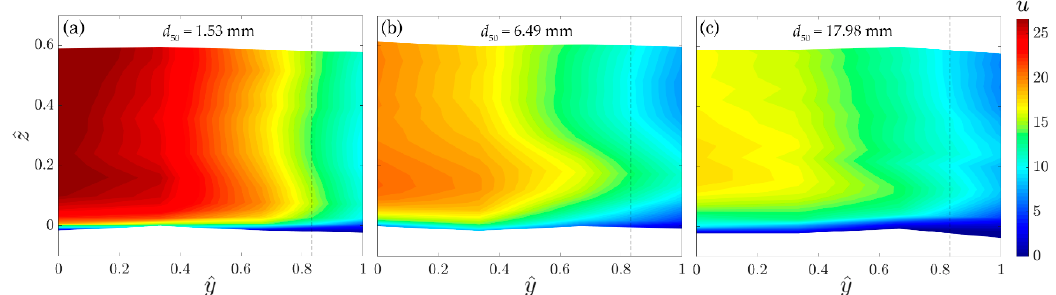
Figure 7. Contours of the dimensionless time-averaged streamwise velocities on the lateral plane (from D to A) for ( a ) Run 1, ( b ) Run 2, and ( c ) Run 3. The black broken line indicates the cylinder location.